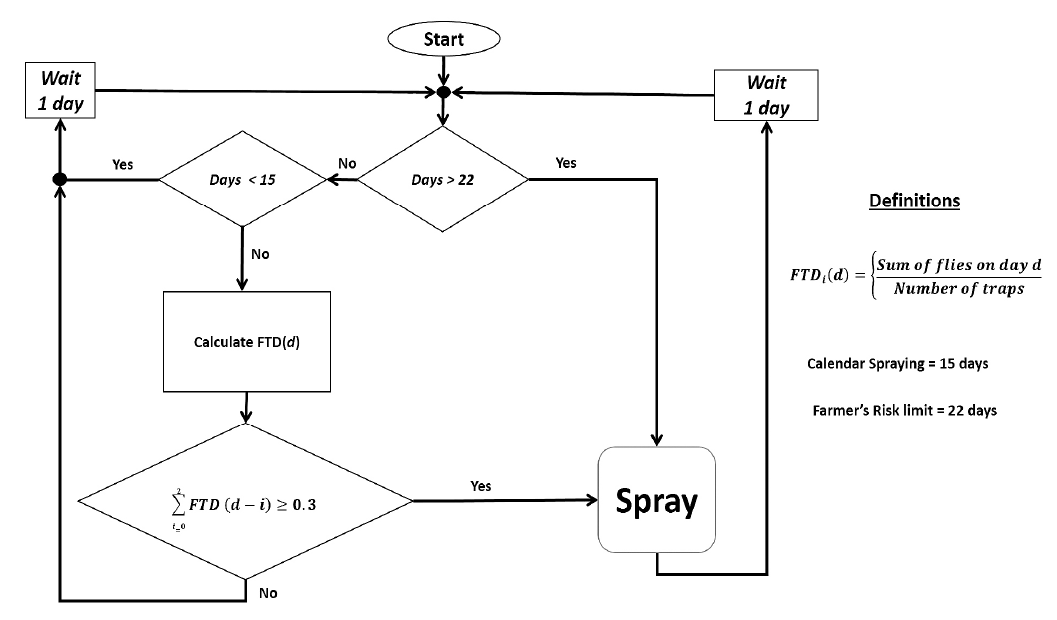
Figure 4. Flowchart of the algorithm developed for the decision-making on pesticide spraying against the Ethiopian fruit fly during melon production in greenhouses in the spring of 2015 in Ein Yahav.